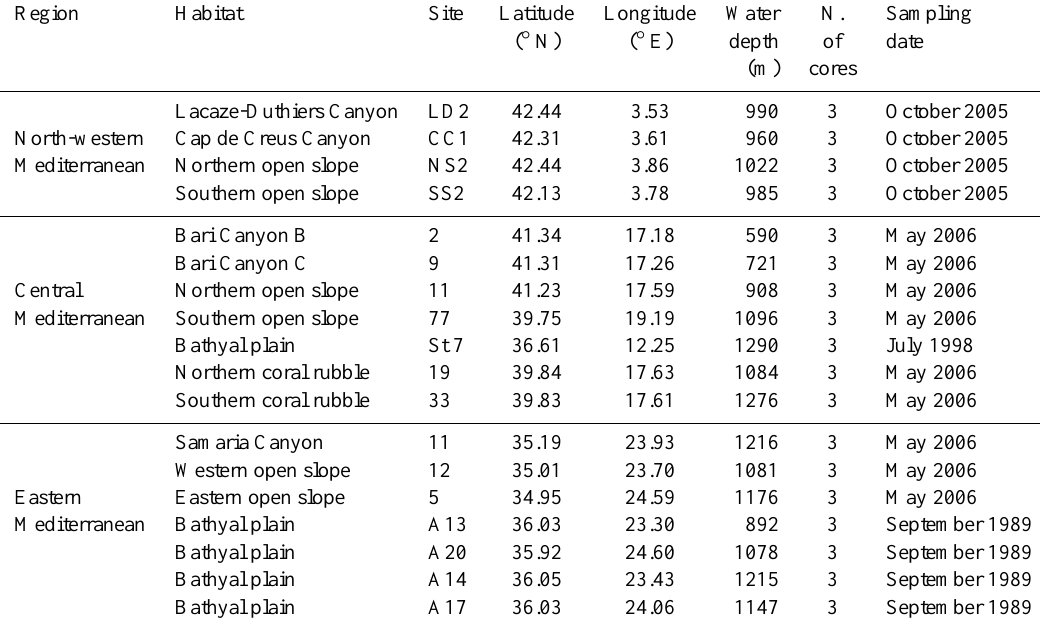
Table 1. Characteristics of the sampling sites in the present study.